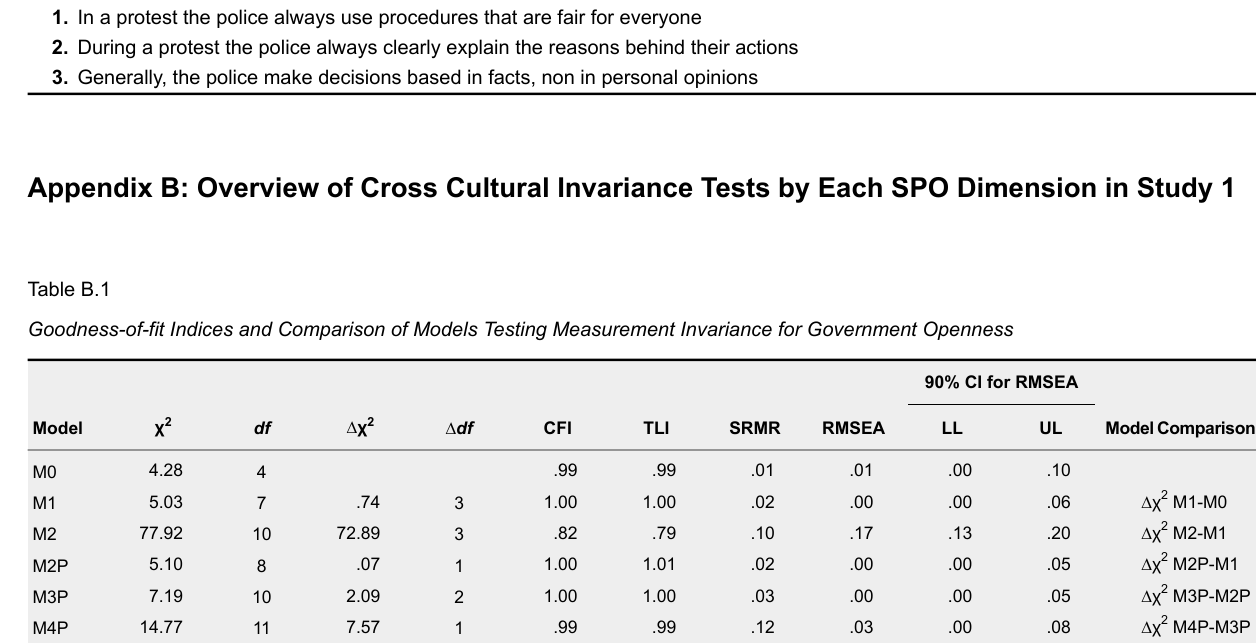
Note. M0 corresponds to the baseline model without any restricted parameter; M1 to the model testing weak invariance; M2 to the